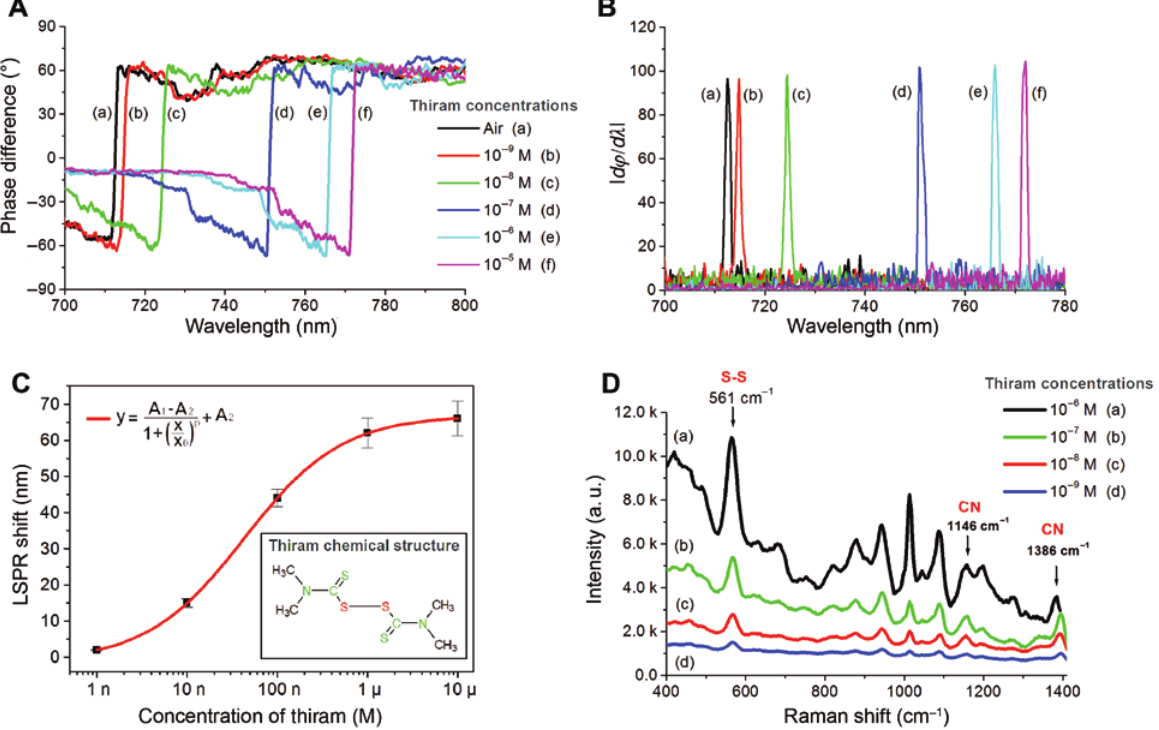
Figure 6: Measurements on ThMo with triangular NPs with d = 180 nm and minimum interparticle distance a = 100 nm realized for different con- centrations of Thiram pesticide: (A) phase difference spectra; (B) absolute differential phase | d ϕ / d λ | associated to resonance peaks; (C) plot of resonant wavelength shift versus different concentrations of Thiram, the red line indicates the fit of the logistic sigmoid function and, in the inset, the chemical structure of the Thiram; (D) SERS spectra of different concentrations of Thiram achieved with a laser wavelength of 785